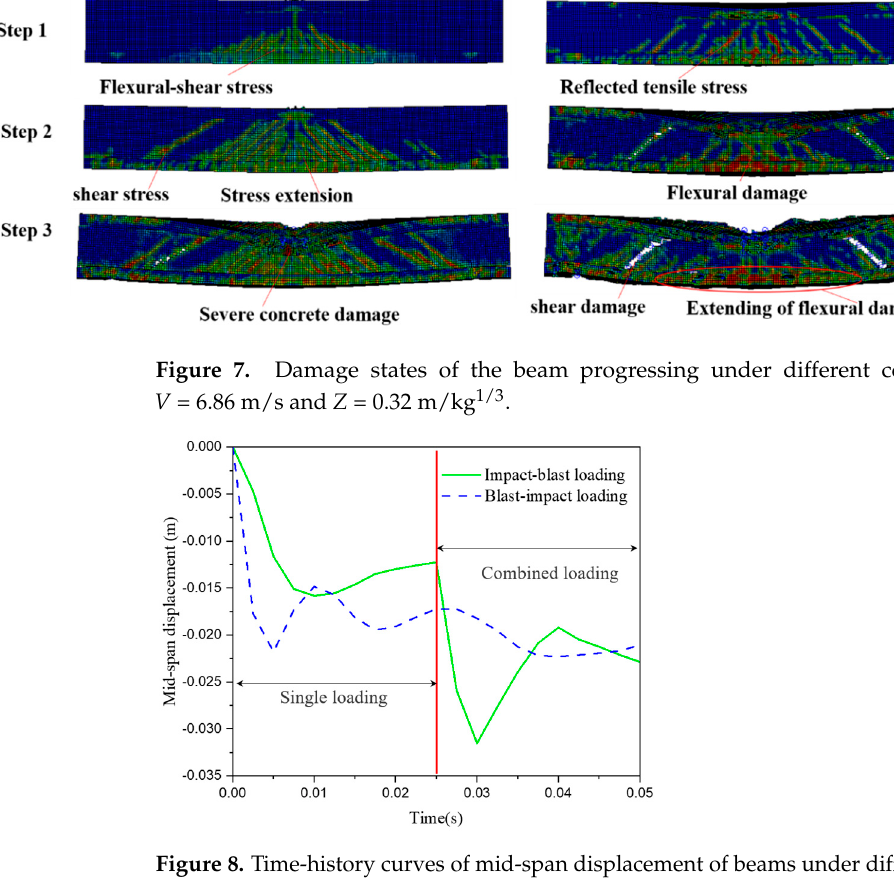
Figure 8. Time-history curves of mid-span displacement of beams under different loading se- quences.